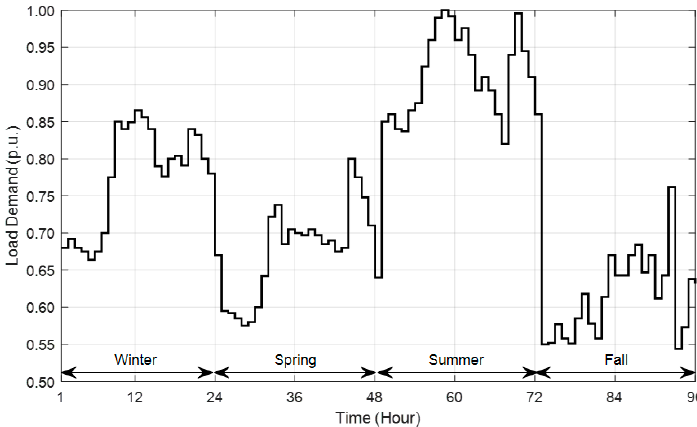
Figure 1. Seasonal load demand variation.